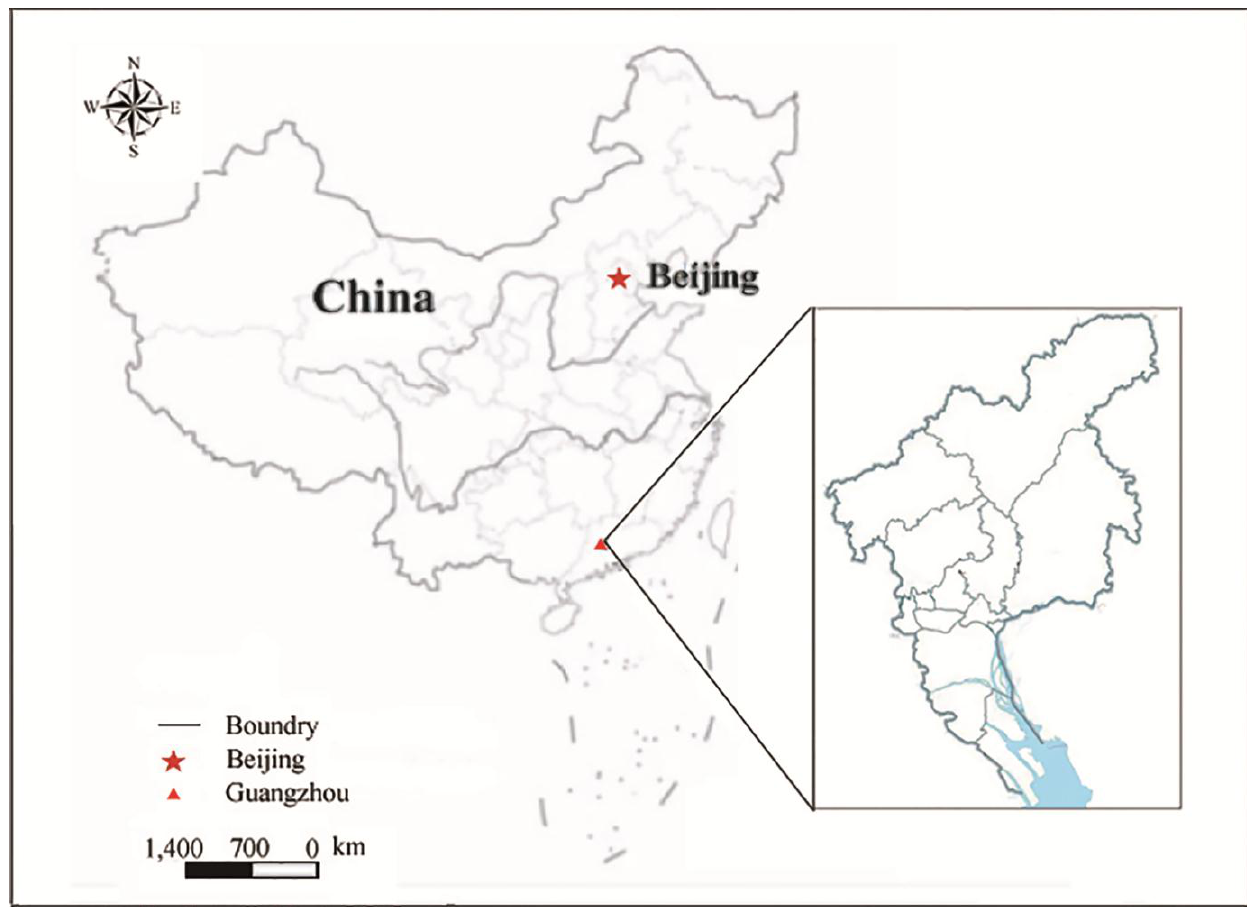
Figure 1. The location of Guangzhou in